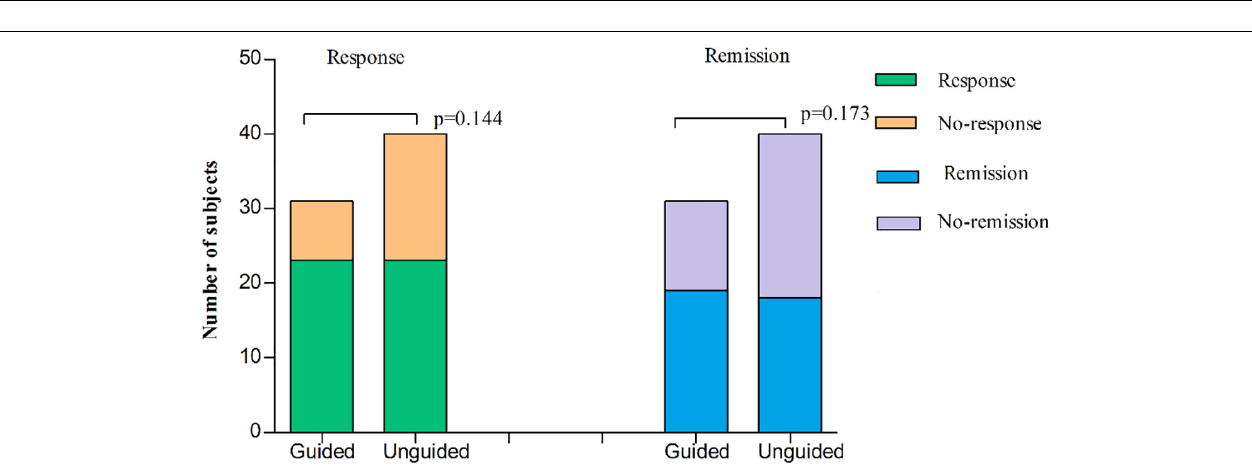
FIGURE 3 | (A) HAMD-17 scores at each time point. Points represent mean scores for each group at each time point. Bars represent SD. (B) The RR of HAMD-17 score at each time point. Values above histogram bars represent group mean scores. Bars represent SD. P -values are derived using the Repeated analyses of covariance. HAMD-17 = 17-item Hamilton depression scale; RR, reduction ratio.